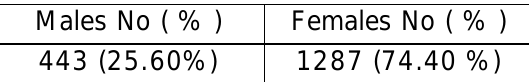
Table 3: Pattern of bacteria isolated from urine culture